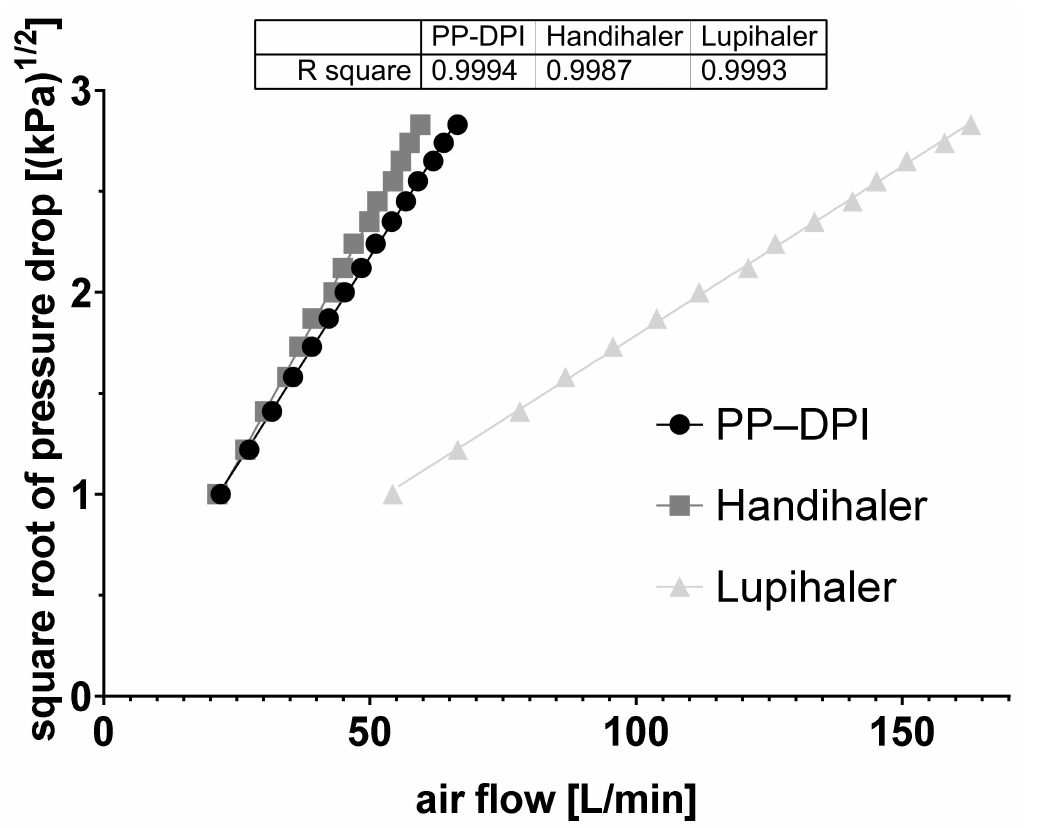
Figure 2. Relationship between the square root of pressure drop and the flow rate (L/min) across the novel (Presspart prototype dry powder inhaler (PP-DPI)) and both marketed DPIs (n = 3, mean ±